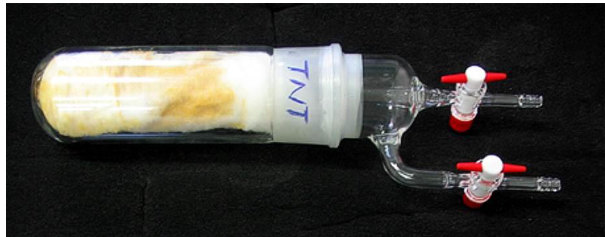
Figure 17. Photograph of a glass cylinder with two Teflon valves on the top. approximately 5 mg of 2× recrystallized TNT was deposited onto glass